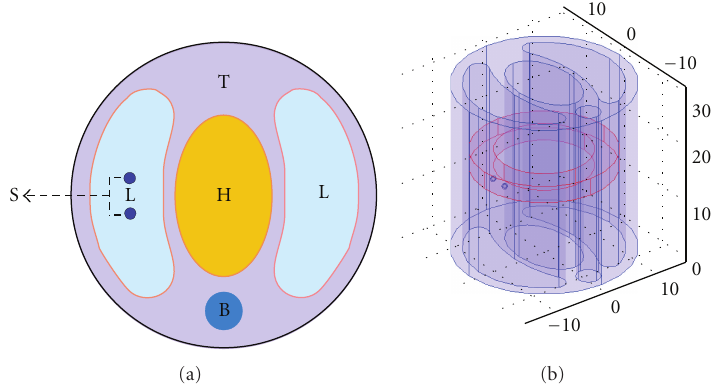
Figure 1: (a) A cross-section through two luminescent sources (S) in the left lung of a mouse phantom consisting of bone (B), heart (H), lungs (L), and tissue (T). (b) A 3D view of the permissible region.